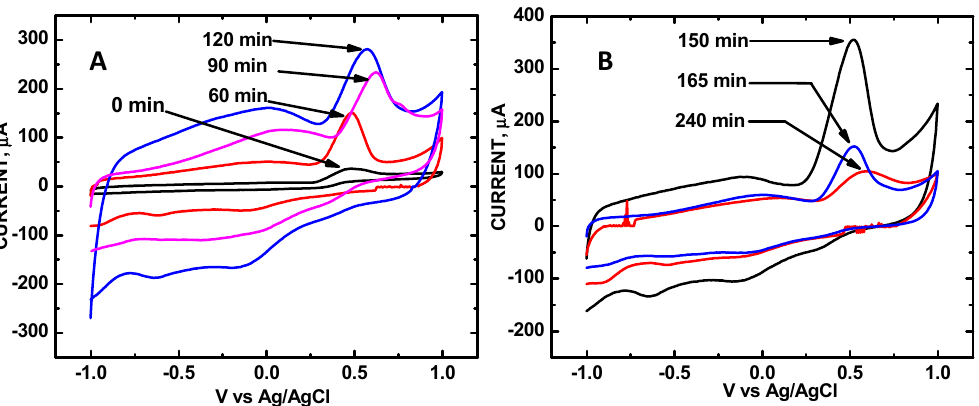
Figure 2. Cyclic voltammetry (CV) of 10 mM UA in PBS (pH = 7.0) from ZnO/COOH-MWNT composites produced at sonication times of ( A ) 0 (control), 60, 90, and 120 min; and ( B ) 150, 165, and 240 min. Scan rate: 50 mV ∙ s –1 . Table 1. CV current peak heights and voltages of ZnO/COOH-MWNTs. Sonication Time,